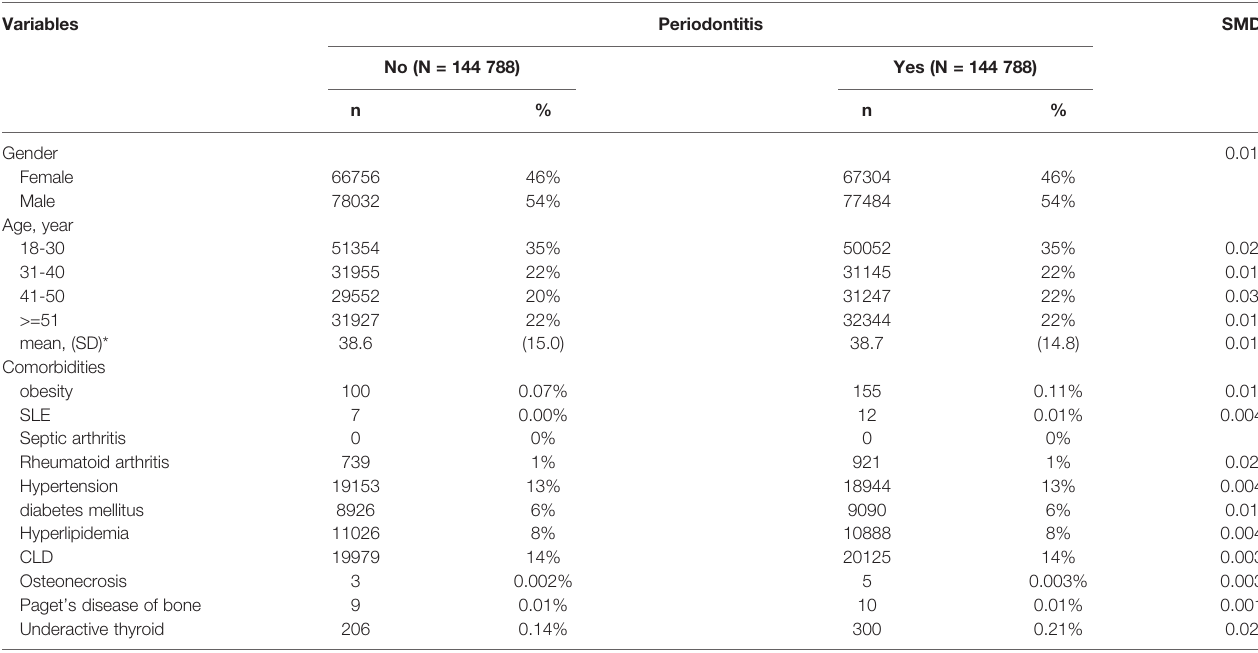
TABLE 1 | Baseline characteristics for the periodontitis and the non-periodontitis cohorts after propensity score matching. Variables